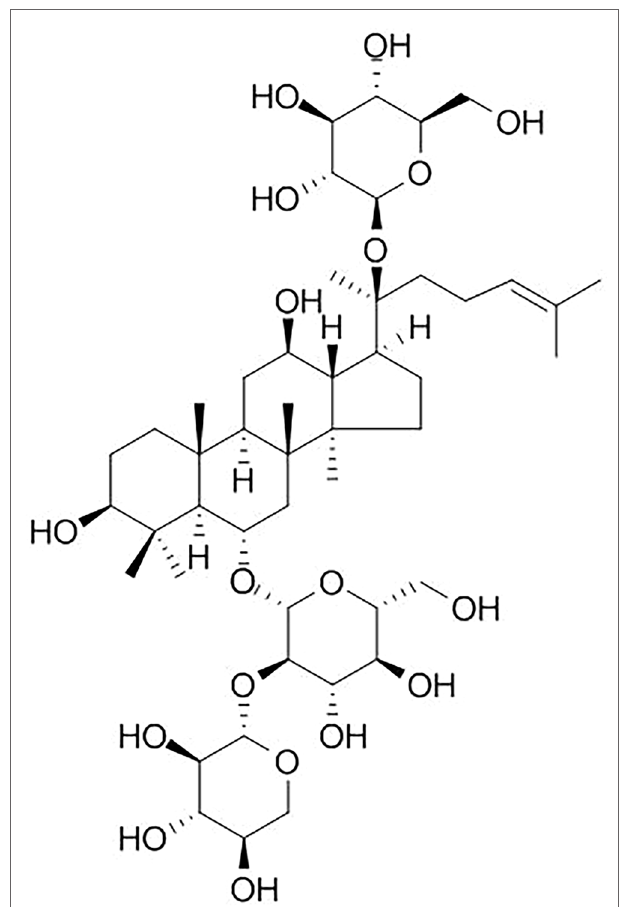
FIGURe 1 | Chemical structure of notoginsenoside